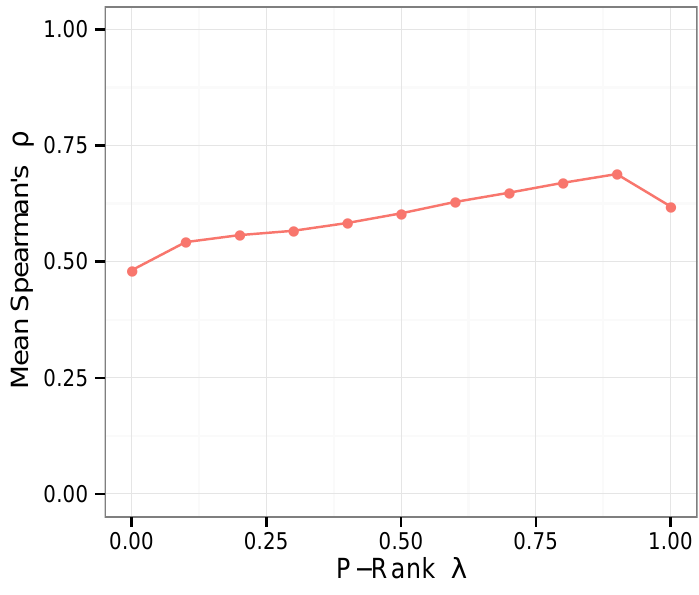
Figure 2. Experiment results grouped by P-Rank in-out link factor λ